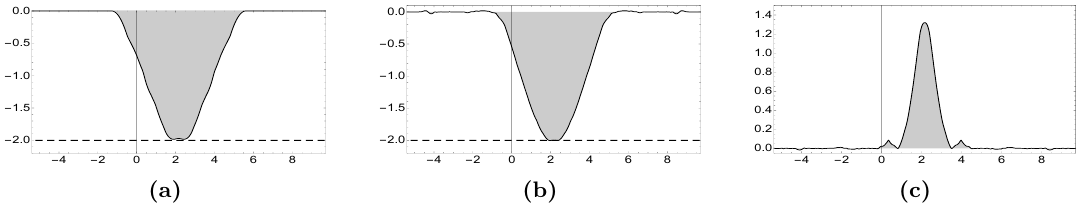
Figure 21. The metastable bounded state for l = 4 : 3146 at (a) t = 7 : 595, (b) t = 17 : 274, (c) t = 32 : 609.